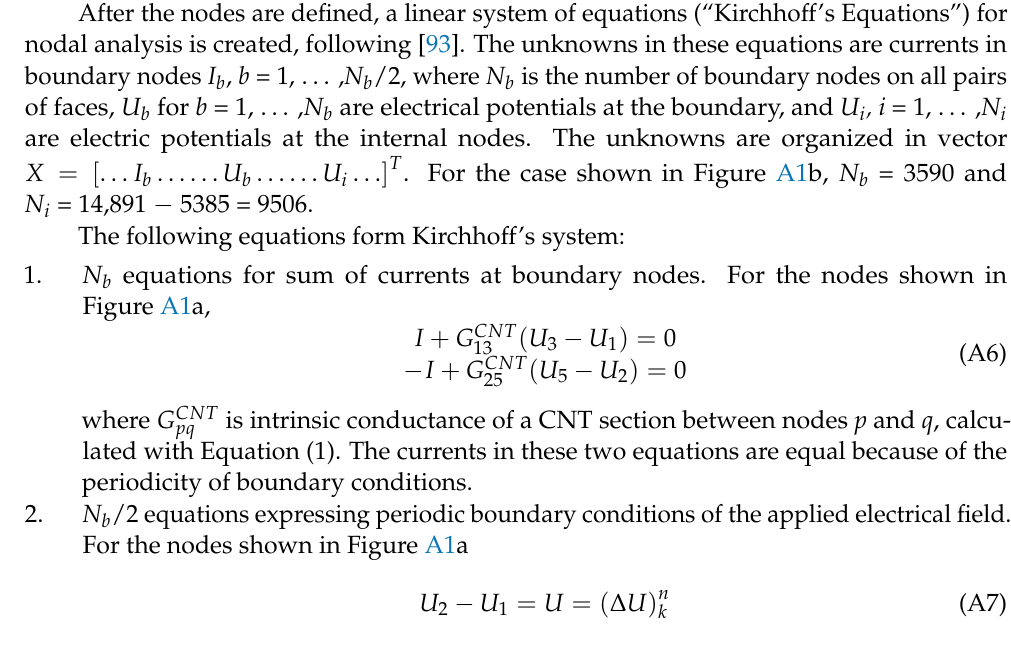
Figure A1b, N b = 3590 and N i = 14891 − 5385 = 9506.